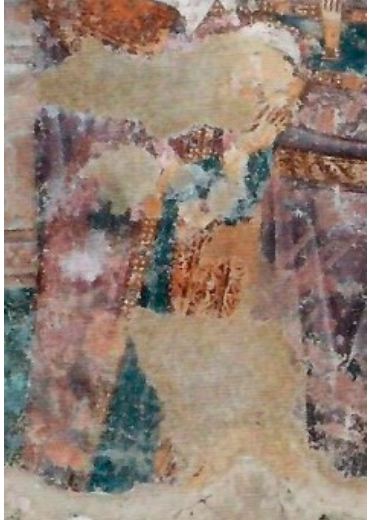
Figure 2. Death of Queen Anne Dandolo. Queen Helen kneeling in front of the scaffolding (detail), 1263–1268. Holy Trinity Church of Sopo ć ani Monastery, northern wall of the narthex, first zone. Photo by Sr đ an Vulovi ć , courtesy of the National Museum of Kraljevo.